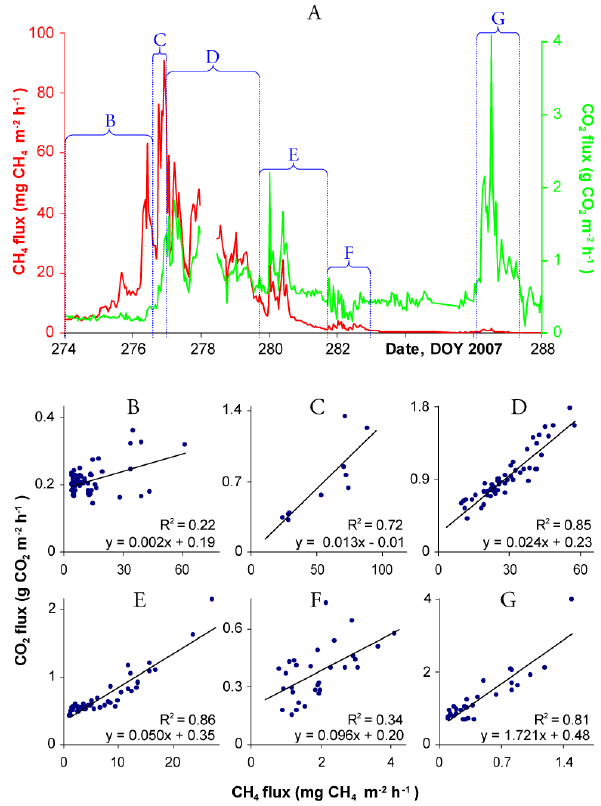
Fig. 7. Examples of freeze-in season dynamics of CH 4 and CO 2 fluxes in one of the chambers. A CH 4 (red, left axis) and CO 2 (green, right axis) fluxes. B–G CO 2 /CH 4 ratio for individual time